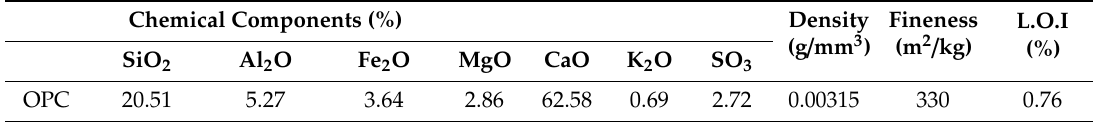
Table 1. The chemical properties of ordinary Portlandite cement (OPC).